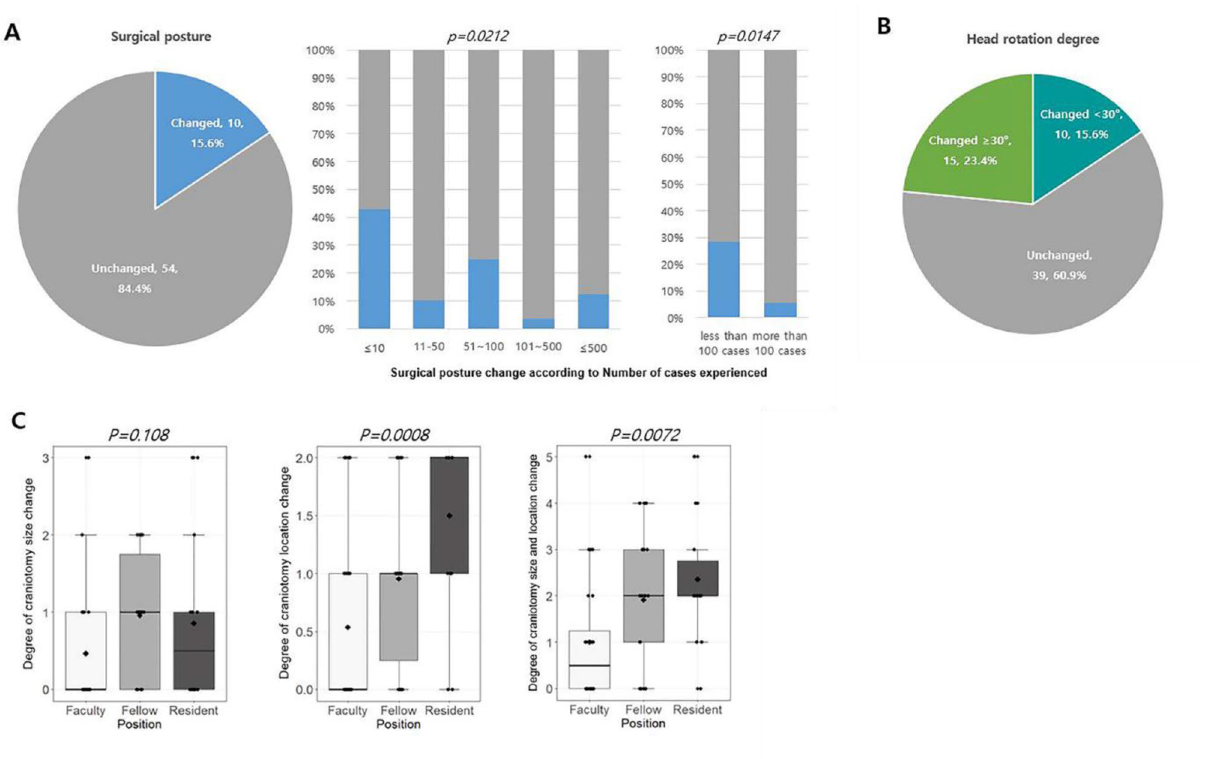
Figure 3. ( A ) Change in surgical posture from that determined from MR images after inspecting the 3D-printed brain tumor model. The surgical posture change rate shows significant differences among respondents according to the number of cases treated. ( B ) Change in head rotation degree from that determined from MR images after inspecting the 3D-printed brain tumor model. ( C ) The degree of change in craniotomy size and location was determined after inspecting the 3D -printed brain tumor model according to the training level of the